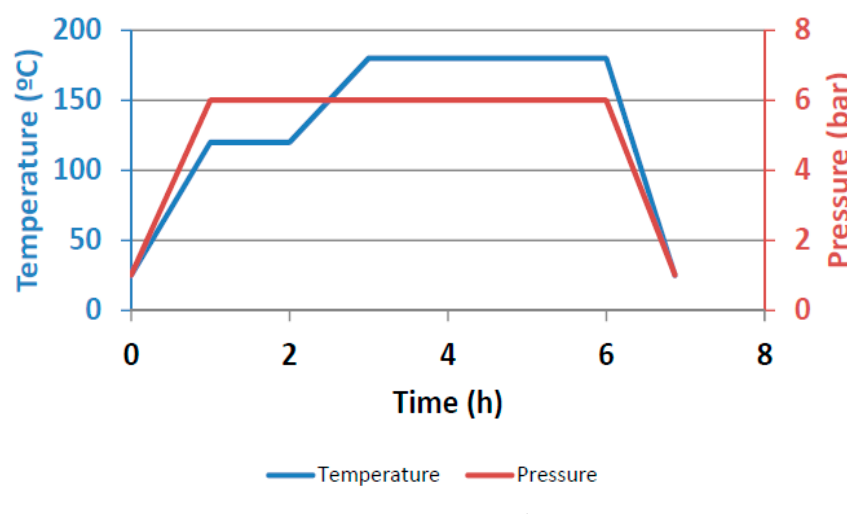
Figure 2. Curing cycle.